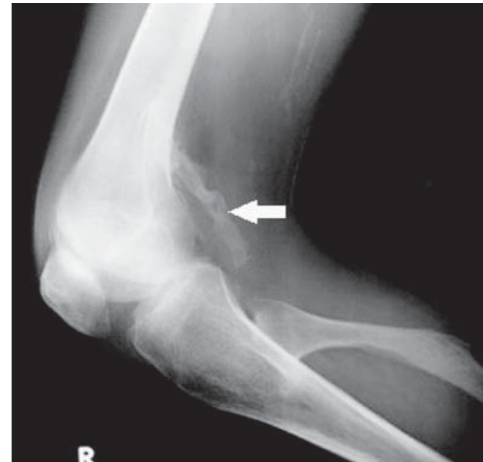
Fig 7. X-ray right knee joint lateral view showing ectopic calcification extending posteriorly from lower end of femur to upper end of tibia (white arrow). Fibula shows pseudo- arthrosis in proximal end.